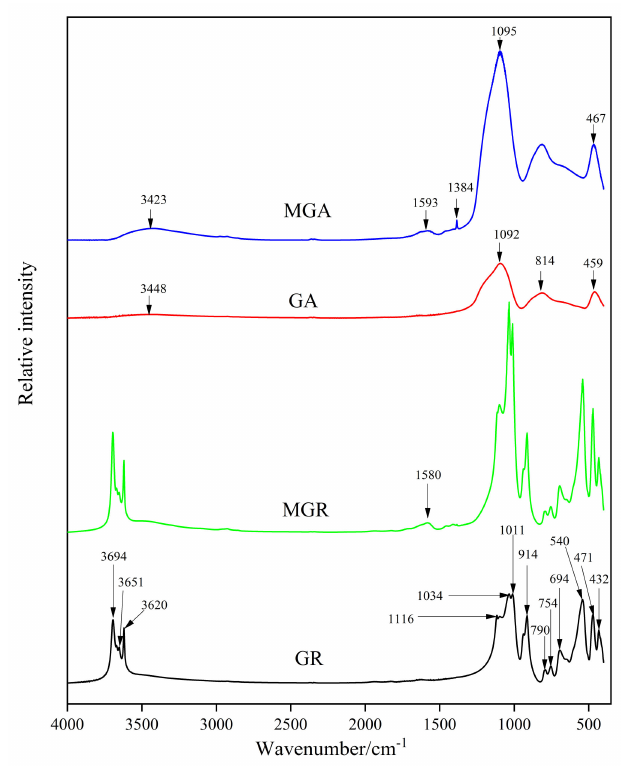
Figure 5. FTIR spectrum of different